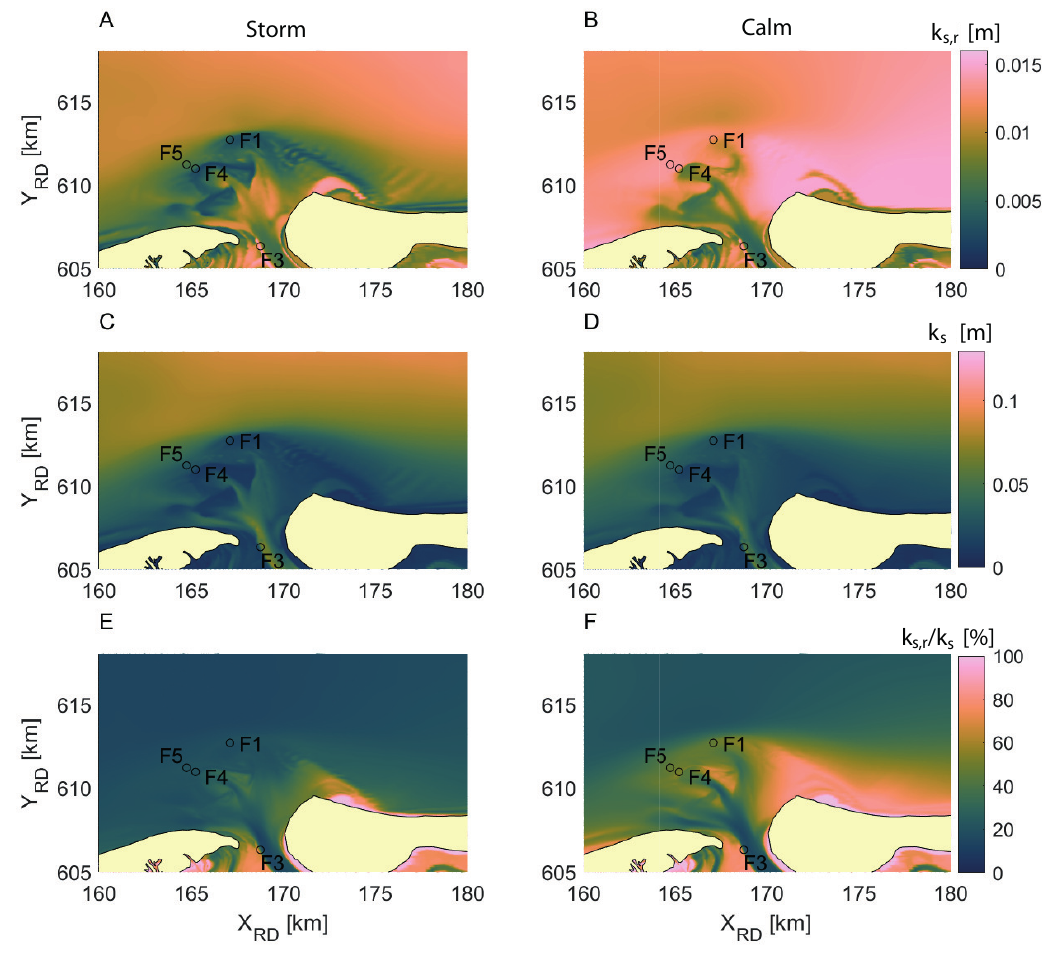
Figure 6. Modelled ripple roughness ( A , B ), total roughness ( C , D ) and ripple roughness as a percentage of total roughness ( E , F ) averaged over time during the storm ( left ) and the calm ( right ) period as denoted in Figure 3 in scenario